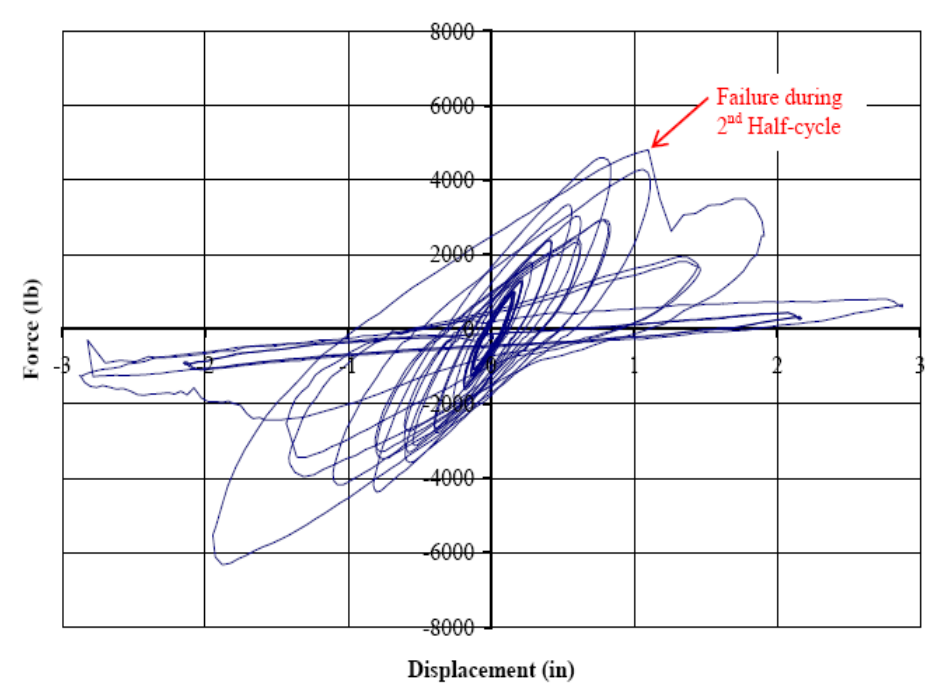
Figure 7. Hysteresis plot for VEwall